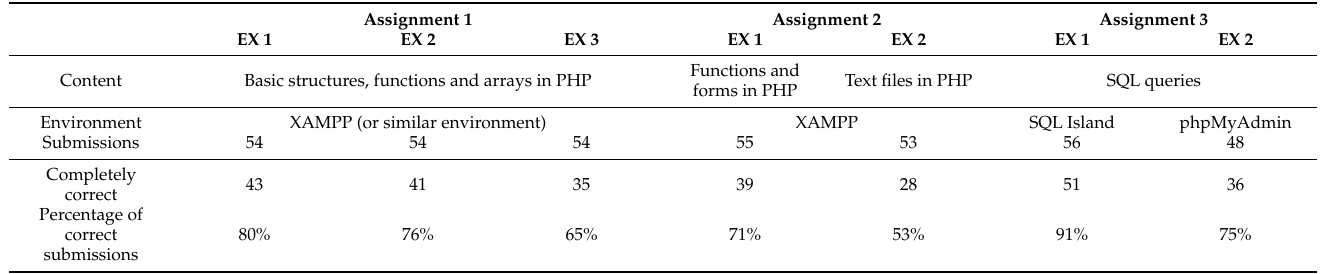
Table 1. Cumulative results for students’ performance on the exercises (EX) of the course.